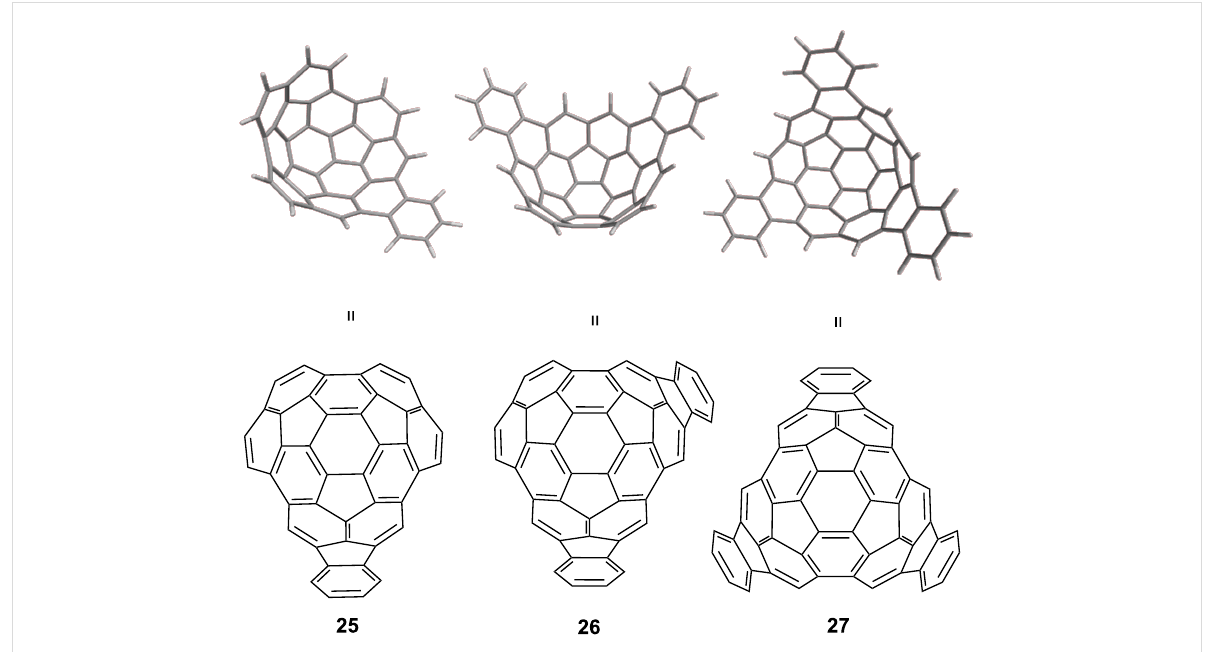
Figure 8: Monoindeno- ( 25 ), diindeno- ( 26 ), and triindenocircumtrindene ( 27 ).